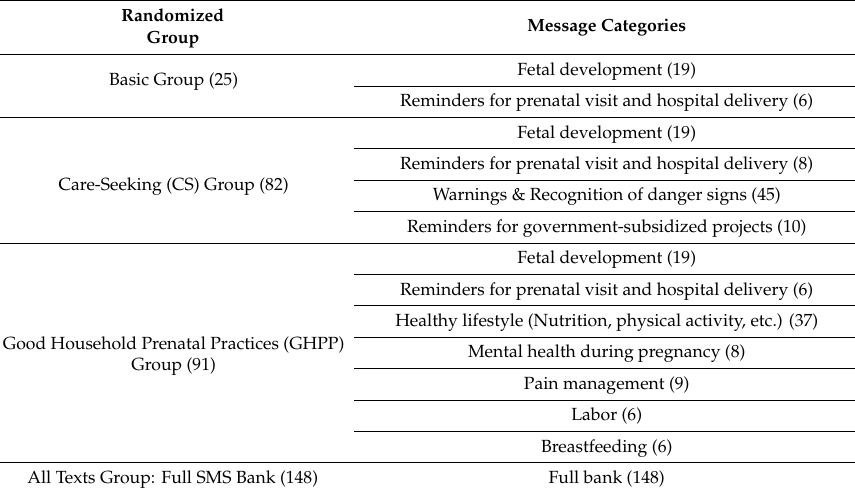
Table 1. Short Message Service (SMS), by General Topic and Treatment